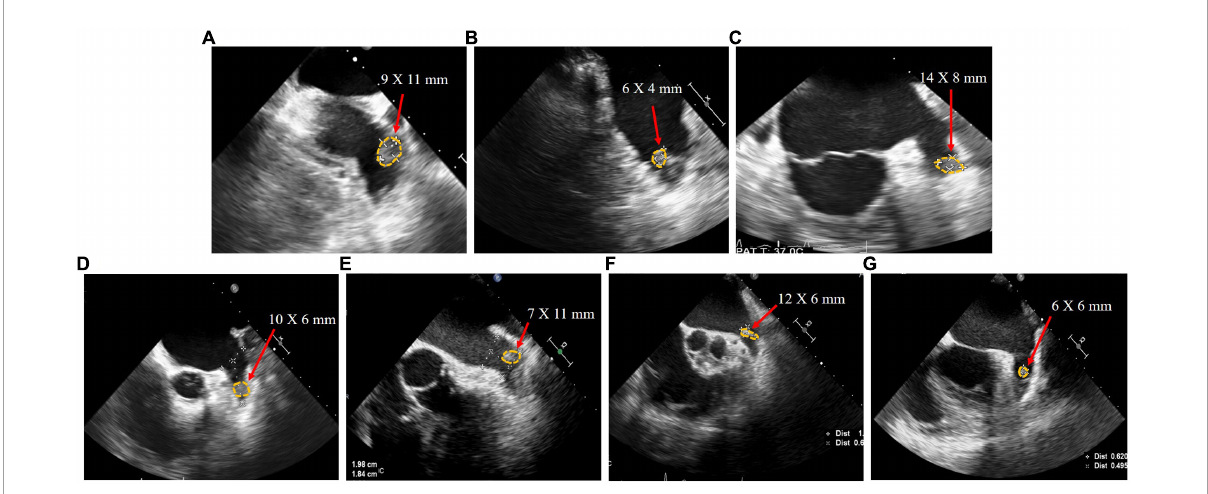
FIGURE2 Transesophageal echocardiography images of patient (A–G) with left atrial appendage thrombus before left atrial appendage closure.